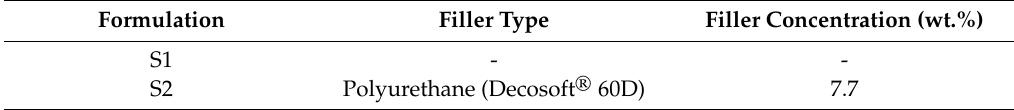
Table 1. Compositions of soft-touch coatings based on polyurethane. Formulation Filler Type